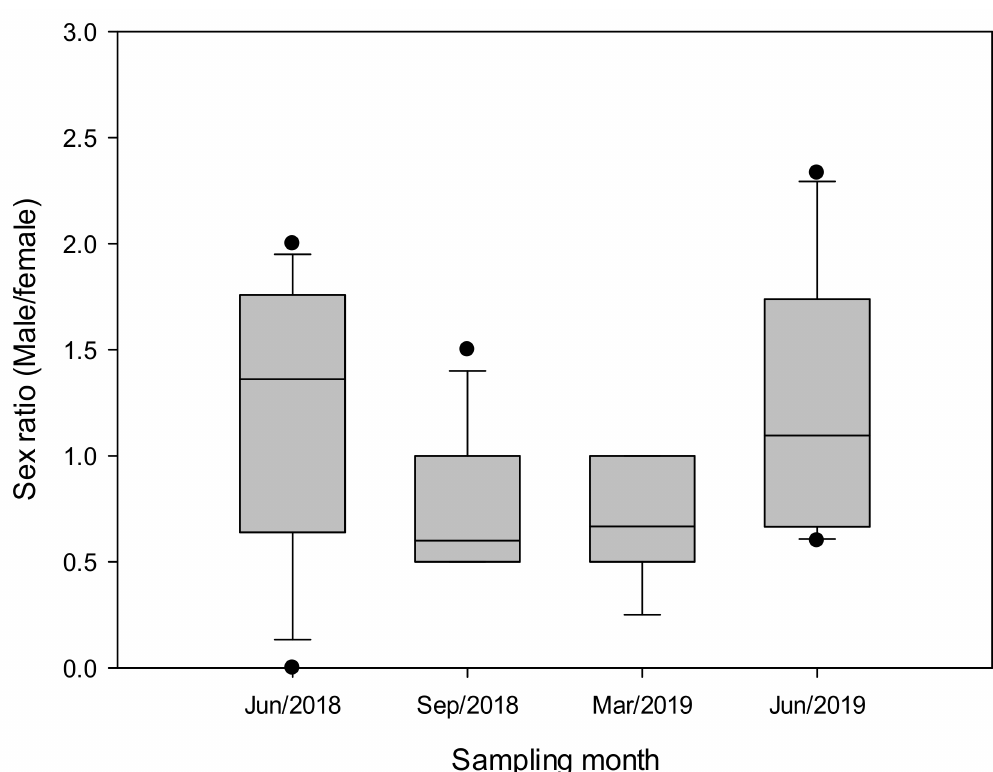
Figure 4. Male to female ratios of adult Temora turbinata during each cruise. The boundary of the box closest to zero and of the box farthest from zero marks the 25th percentile and the 75th percentile, respectively; a line within the box indicates the median. Whiskers (error bars) above and below the box mark the 90th and 10th percentiles.